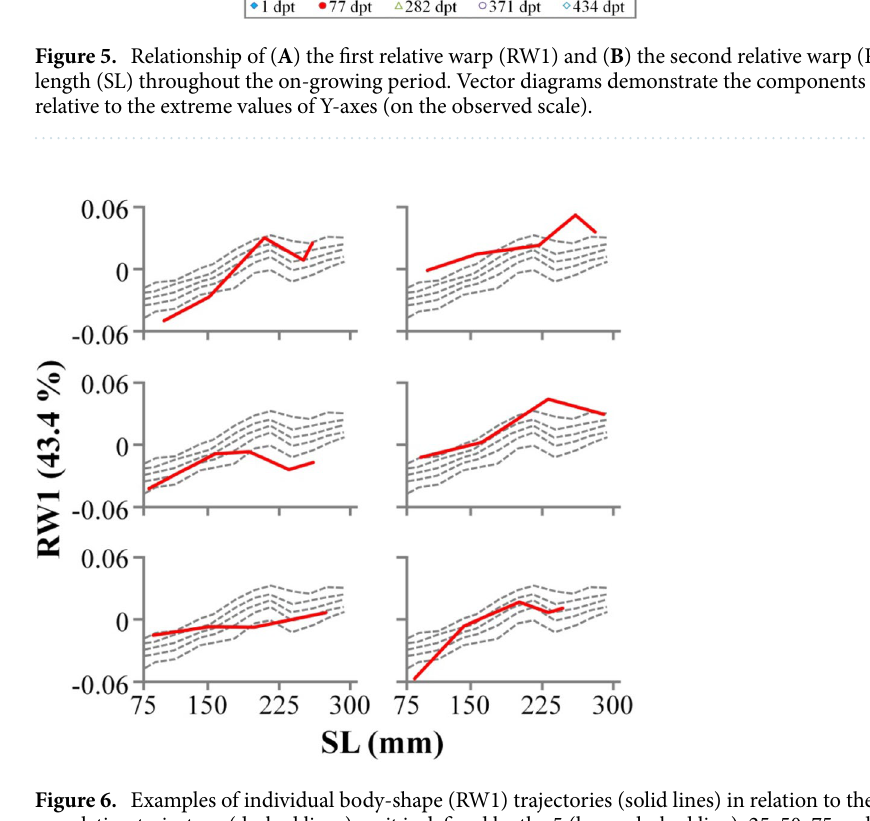
Figure 6. Examples of individual body-shape (RW1) trajectories (solid lines) in relation to the consensus population trajectory (dashed lines), as it is defined by the 5 (lower dashed line), 25, 50, 75 and 95 (upper dashed line)